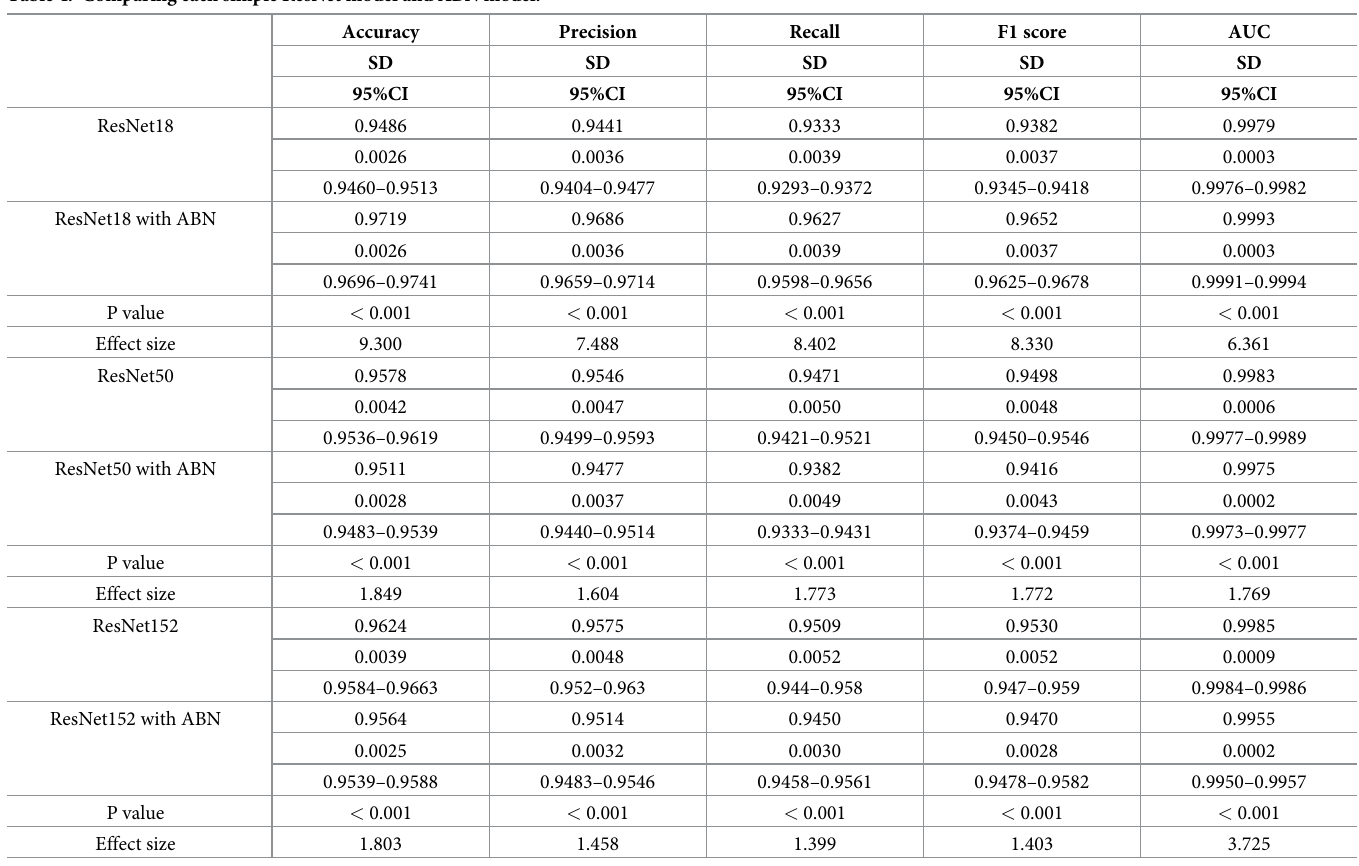
Table 4. Comparing each simple ResNet model and ABN